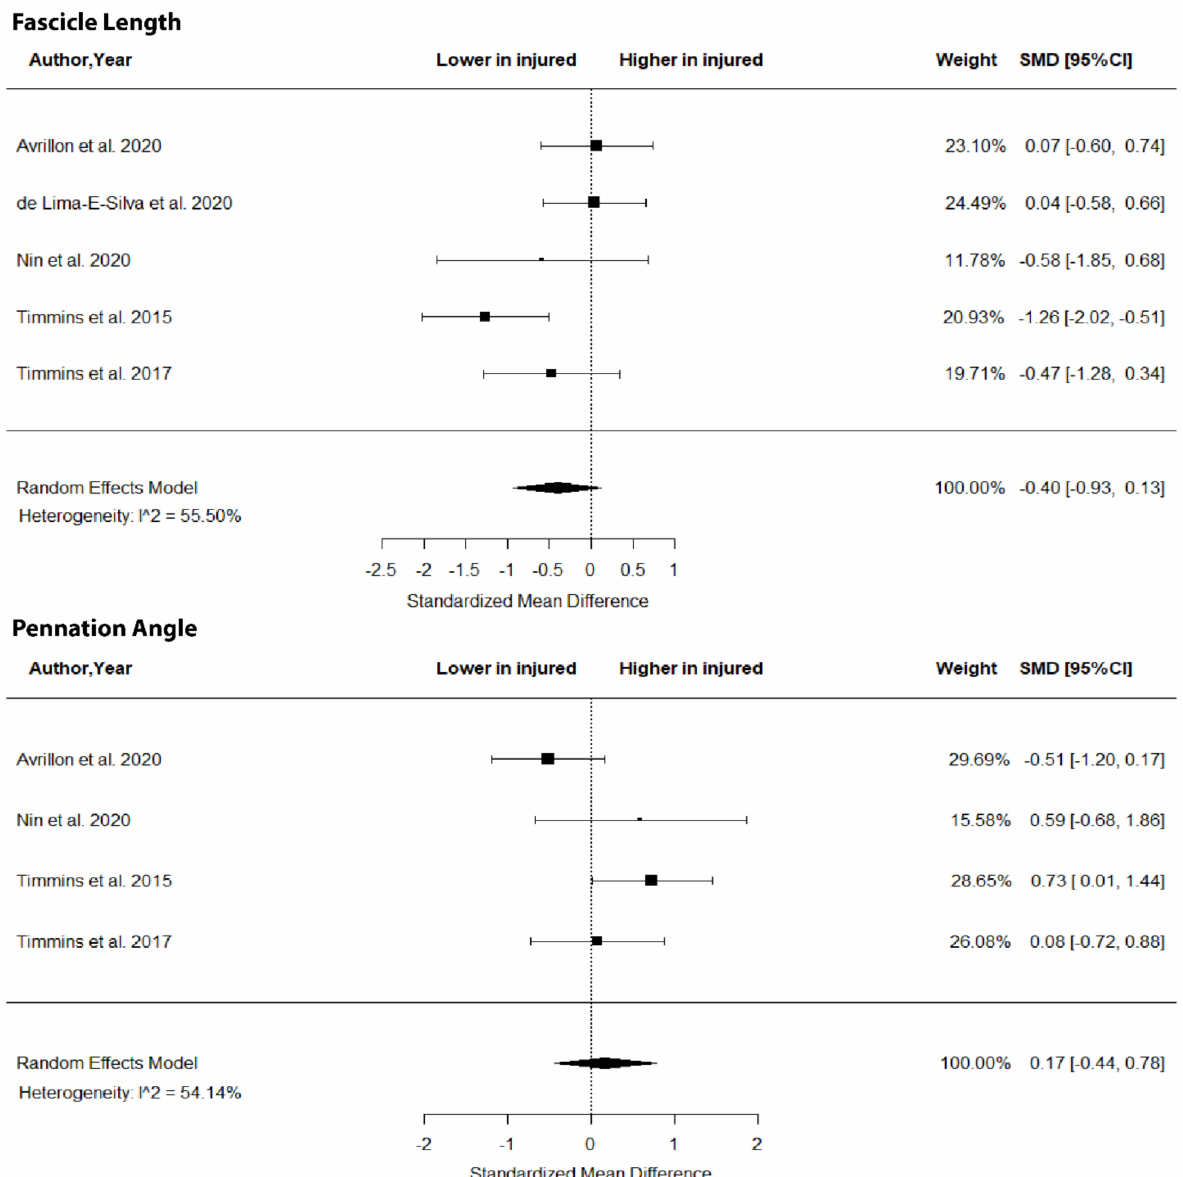
Figure 2. Forest plot of biceps femoris long head fascicle length and angle of pennation in injured versus contralateral limb of athletes with a previous hamstring